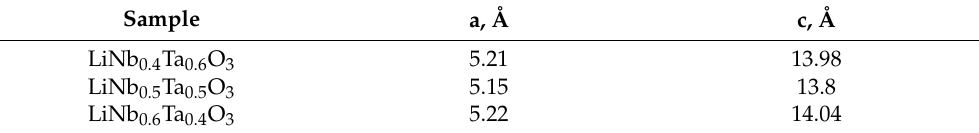
Figure 1. Picture of studied samples. Table 1. Structural characteristics of the crystal lattices of the studied ceramic solid solutions [8].